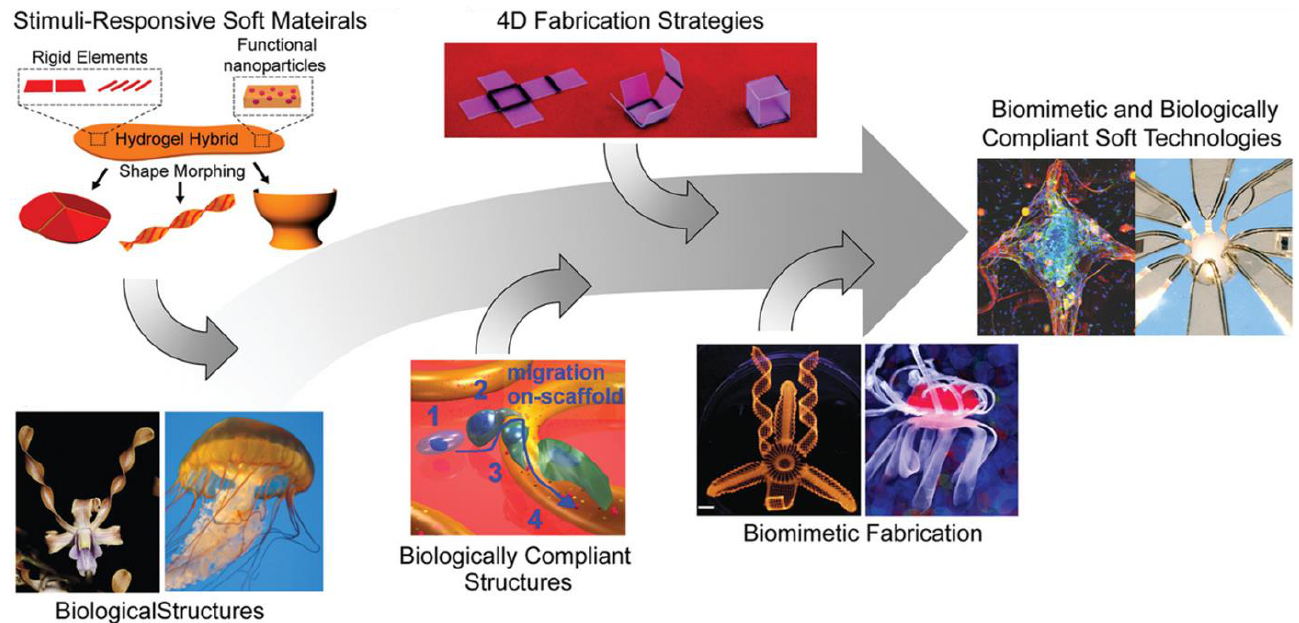
Figure 8. Multi-material 4D printing for biomimetics. Reproduced with permission from [136]. Copyright © 2019 Wiley.